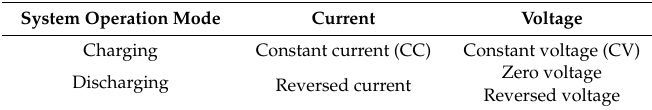
Table 2. Types of electric operational modes in capacitive deionization (CDI) for charging and discharging